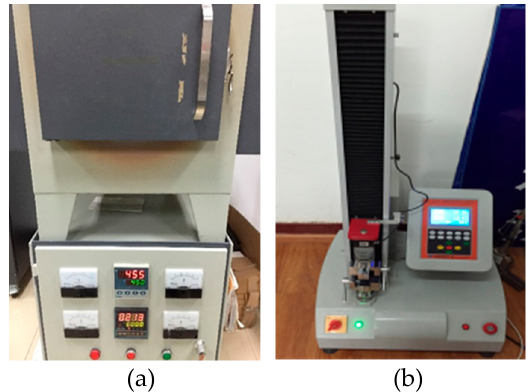
Figure 6. Heating and tension test equipment: ( a ) the oven; ( b ) the tensile test machine.